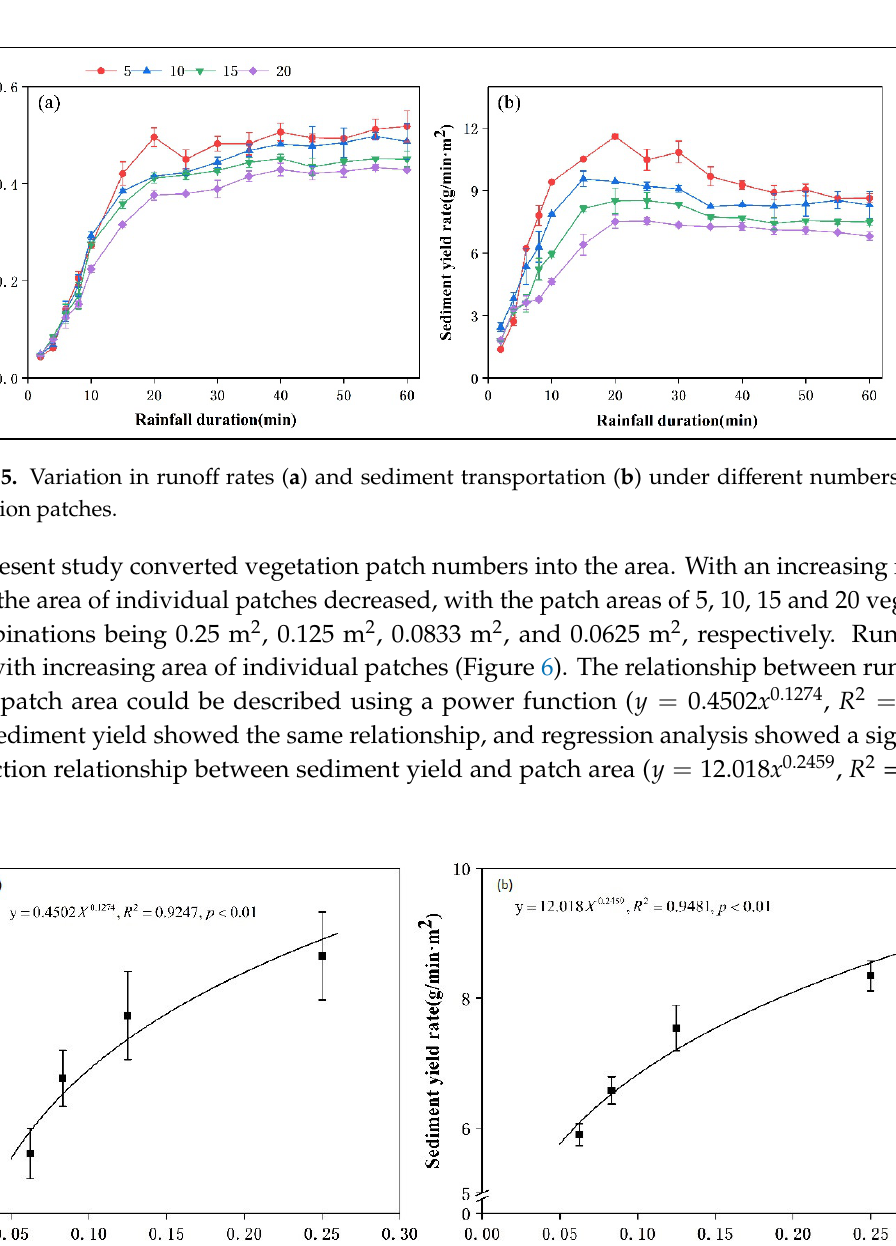
Figure 7. Between surface runoff and soil loss for different vegetation patch types ( a ) and numbers ( b ) within an experiment.